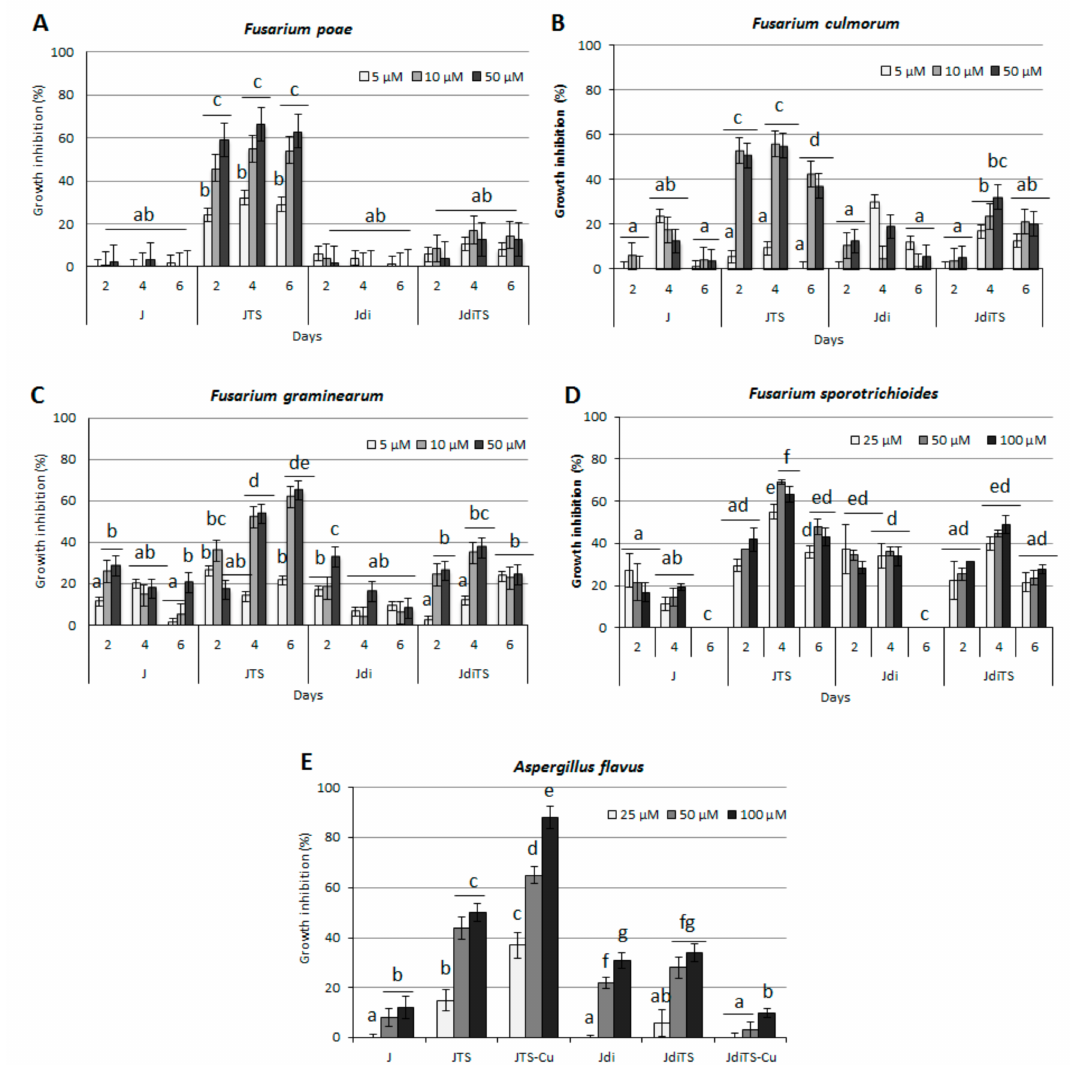
Figure 4. E ff ects of the compounds on the growth of cereals pathogenic fungi ( A ) F. poae , ( B ) F. culmorum , ( C ) F. graminearum , ( D ) F. sporotrichioides and ( E ) A. flavus . Culture medium was amended with an increasing concentration of molecules (from 5 to 100 µ M) on the basis of the species; values are reported as inhibition percentage as compared to the control (DMSO amended cultures) ± S.D. Di ff erent letters indicate statistically significant di ff erences ( p <